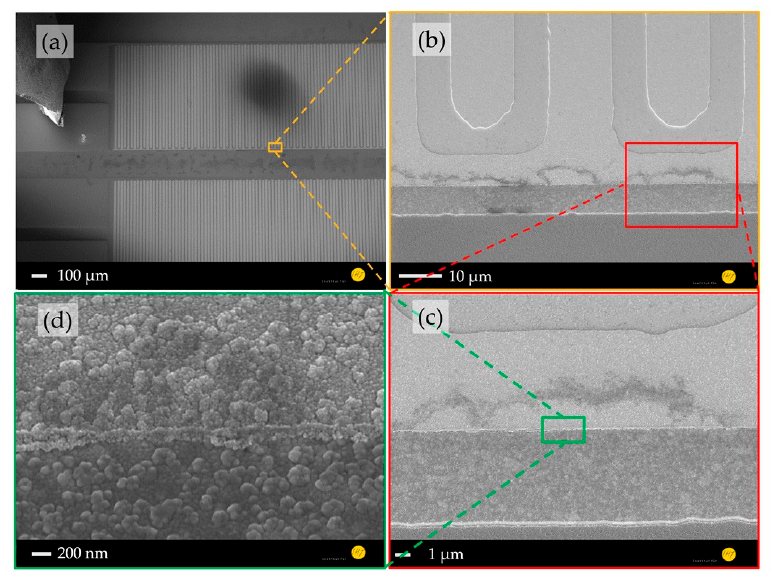
Figure 2. SEM images of gas sensor platform comprising planar ZnO/AlN thin films: ( a ) whole device, ( b ) electrode area covered by a ZnO seed layer, ( c ) layer stack of AlN/Au-electrode/ZnO, and ( d ) ~300 nm ZnO seed layer on an Au electrode.